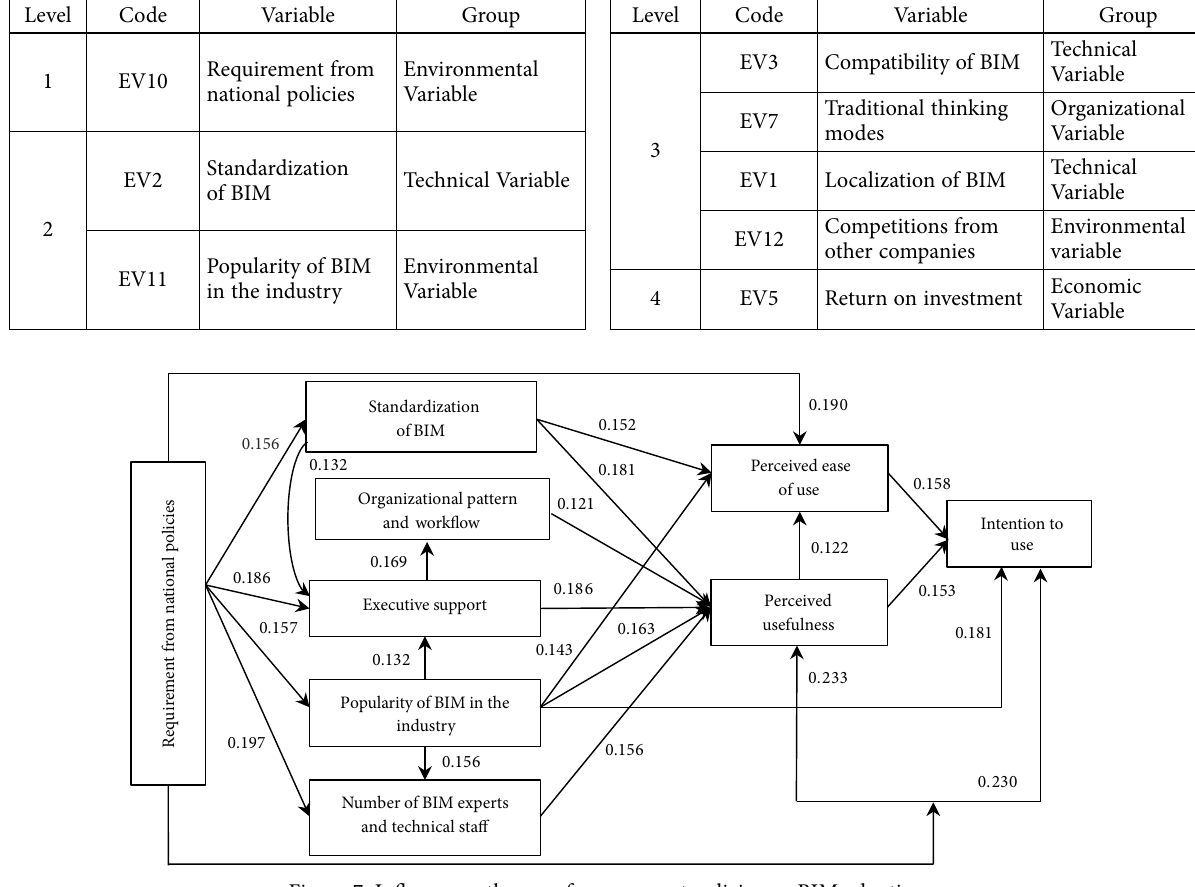
Figure 7. Influence pathways of government policies on BIM adoptions